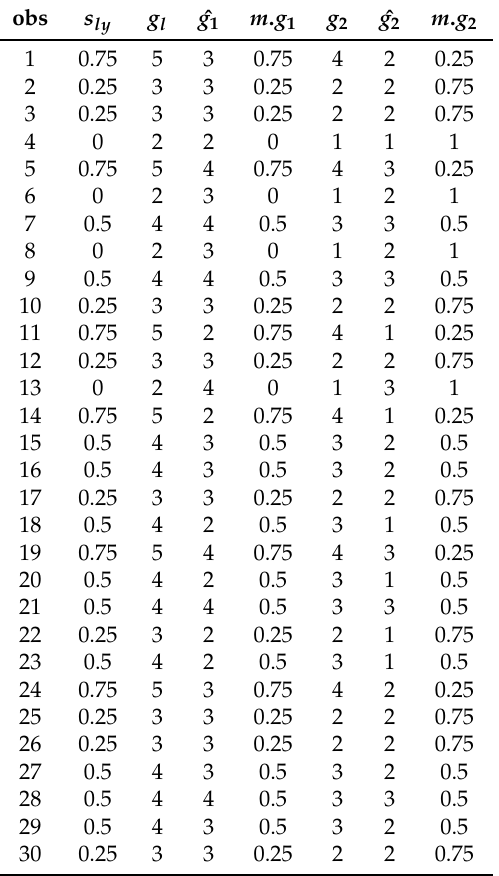
Table 2. The predicted groups based on the overlapped basic